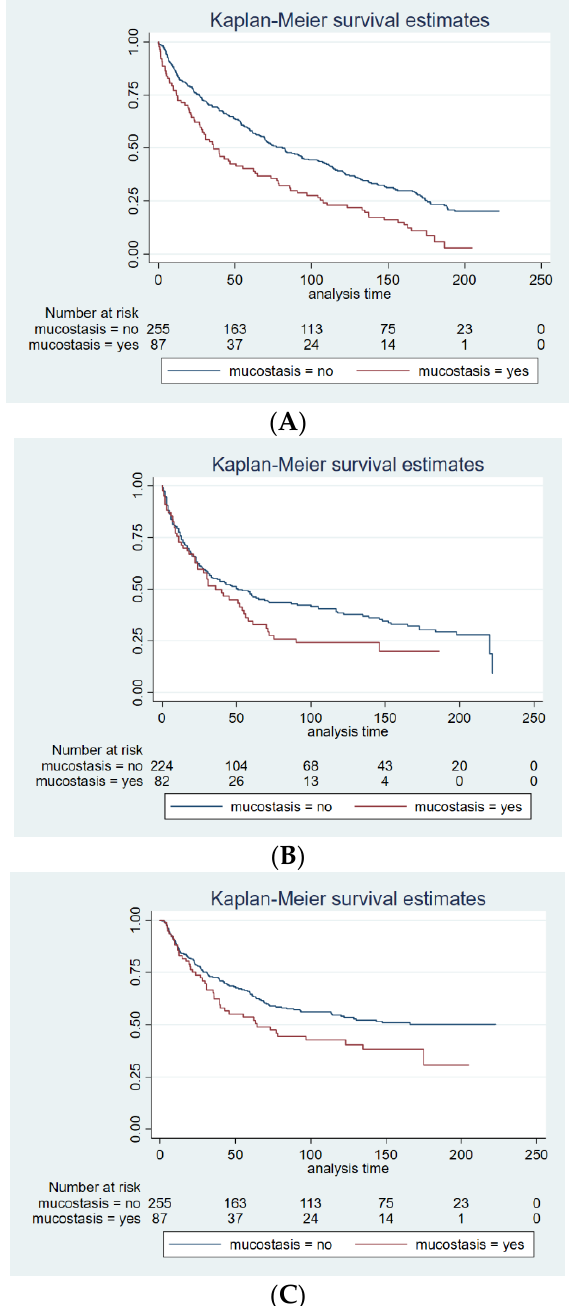
Figure 1. ( A ) Kaplan–Meier curves comparing the 10-year survival rates between those patients with postoperative mucostasis and those without among the collective of 342 patients undergoing curative resection for NSCLC showing OS ( p < 0.001). Abbreviations: OS: overall survival, NSCLC: non-small cell lung cancer. ( B ) . Kaplan–Meier curves comparing the 10-year survival rates between those patients with postoperative mucostasis and those without among the collective of 342 patients undergoing curative resection for NSCLC showing RFS ( p = 0.009). Abbreviations: RFS: recurrence free survival, NSCLC: non-small cell lung cancer. ( C ) Kaplan–Meier curves comparing the 10-year survival rates between those patients with postoperative mucostasis and those without among the collective of 342 patients undergoing curative resection for NSCLC showing CSS ( p = 0.008). Abbreviations: CSS: cancer specific survival, NSCLC: non-small cell lung cancer.